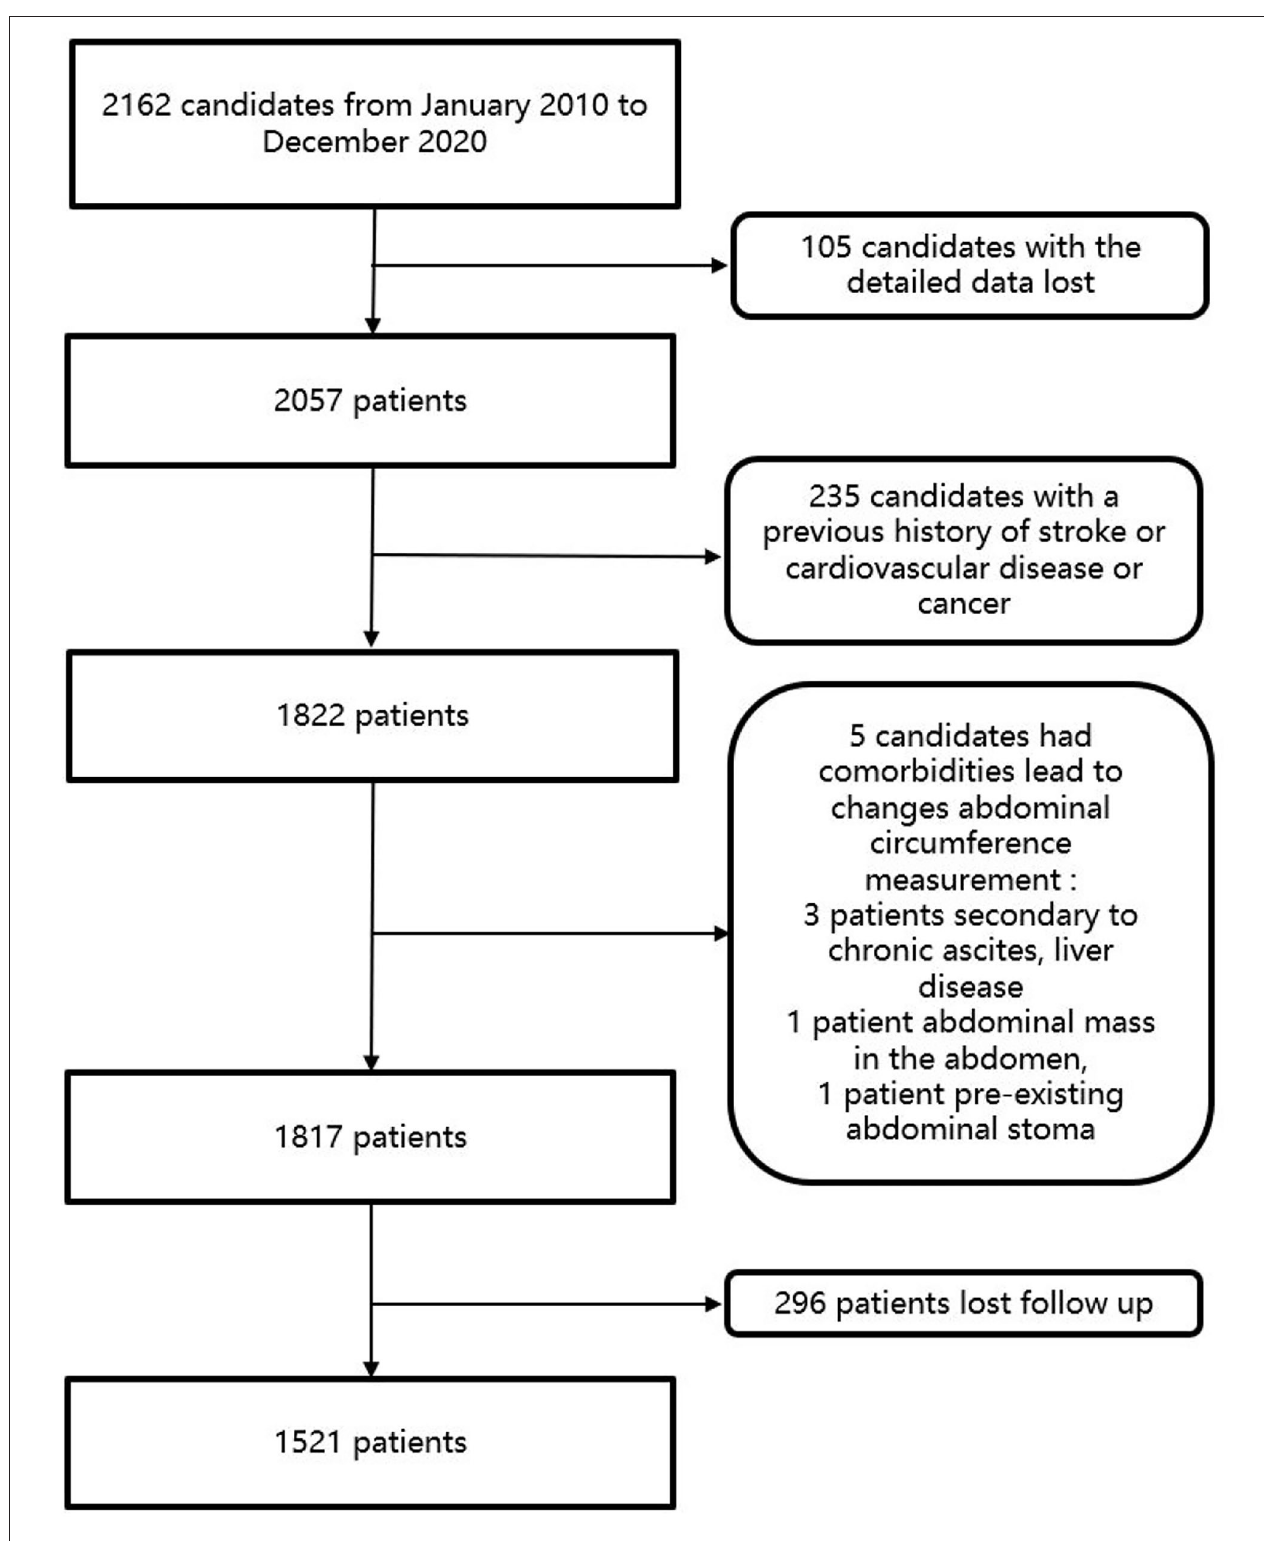
FIGURE 1 | The flowchart of the